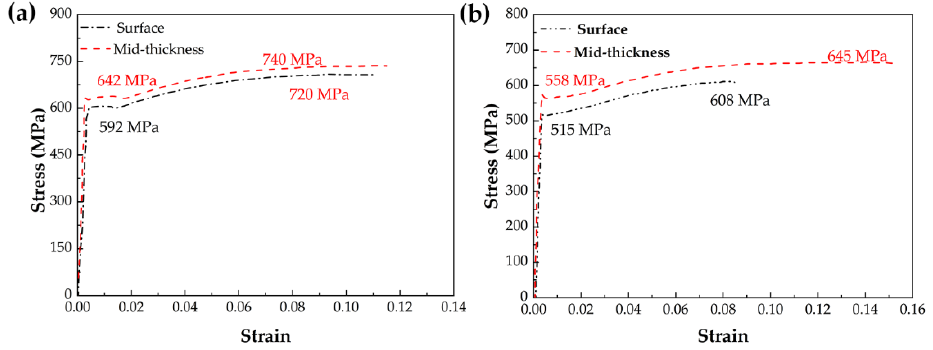
Table 3. Mechanical properties obtained from the surface and mid-thickness of steel A and B plates.